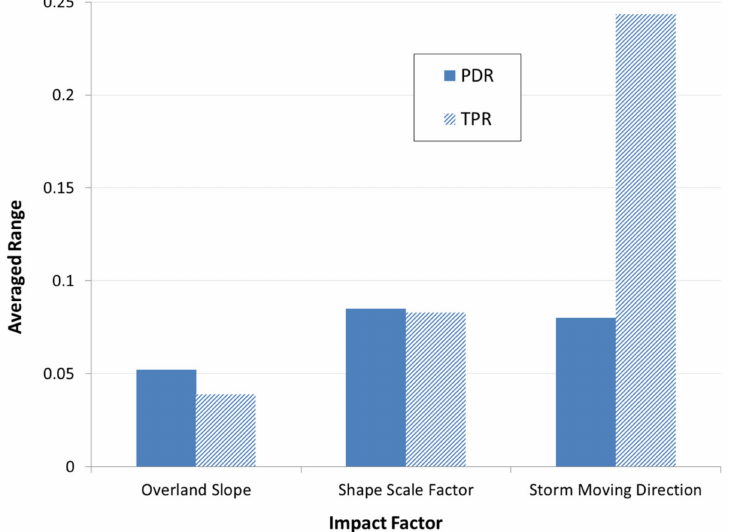
Figure 9. The averaged range of PDRs and TPRs due to overland slope, shape scale factor and storm moving